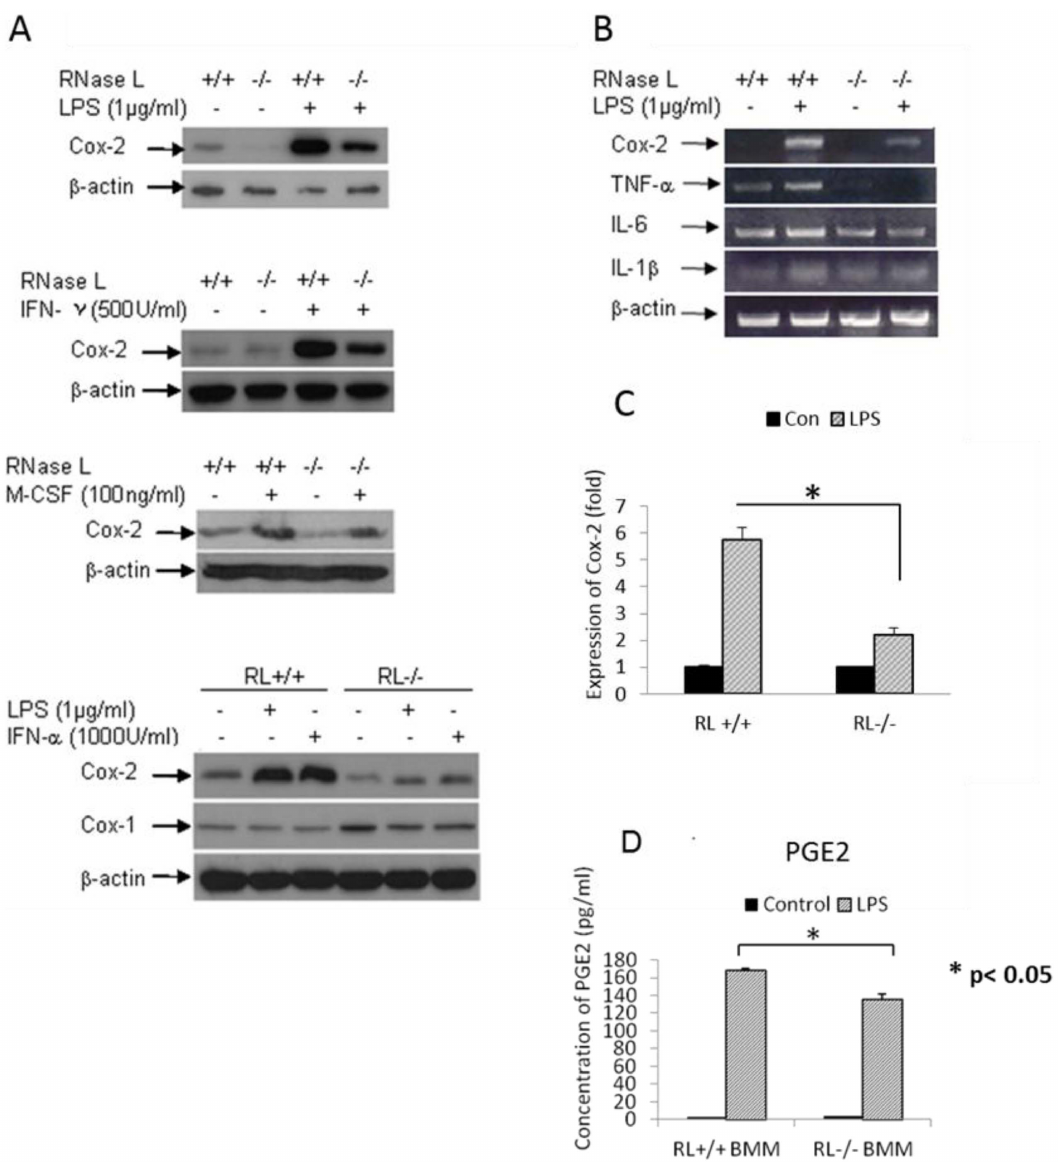
Figure 4. RNase L regulates the expression of Cox-2. RNase L deficient and wild type BMMs were treated with 1 m g/ml of LPS, 1,000 units/ml of IFN- a , 500 units/ml of IFN- c , and 100 ng/ml of M-CSF for 14 h. The expression of Cox-2 was determined by Western blot analysis using a monolocnal antibody against mouse Cox-2 (A). RNase L wild type and deficient MEFs were treated with 1 m g/ml of LPS for 14 h. Total RNAs were isolated by using the Trizol Reagent (Invitrogen, CA). The expression of Cox-2, TNF- a , IL-6 and IL-1 b was determined by RT-PCR (B). The expression of Cox-2 was measured by real-time PCR (C), which was performed twice in triplicate; the fold change from one of the experiments is present as Mean 6 SD, *p , 0.05. The production of PGE2 in the media culturing the two types of BMMs treated with LPS as described above was analyzed by ELISA (D). Experiments were performed twice in triplicates. Data are presented as Mean 6 SD, *p , 0.05. doi:10.1371/journal.pone.0081269.g004 which contributes to the differentiation, survival, proliferation and (protease-dependent) migration mode depending on the environ- mental constraints to migrate to the site of infection and targeting spots [31]. Macrophages are recruited to specific sites by chemotaxis which directs cell migration towards chemoattractant gradients. The cell senses a gradient and moves by extending actin-rich protrusions towards the chemoattractant propelled by actin-myosin mediated contractions [32]. RNase L seems to play a critical role in the M-CSF induced cell migration and deficiency of RNase L in macrophages reduced about 50% of migrated cell RNase L is involved in M-CSF-induced macrophage migration population. M-CSF is a pleiotropic macrophage growth factor,